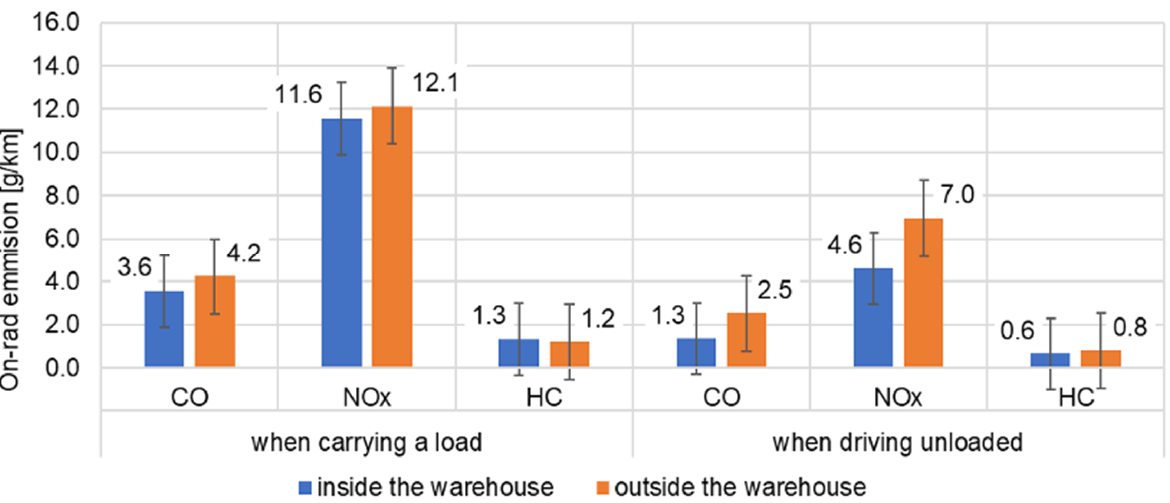
Figure 4. Comparison of the road emissions of individual exhaust components for individual stages of the forklift operation in a single test run.